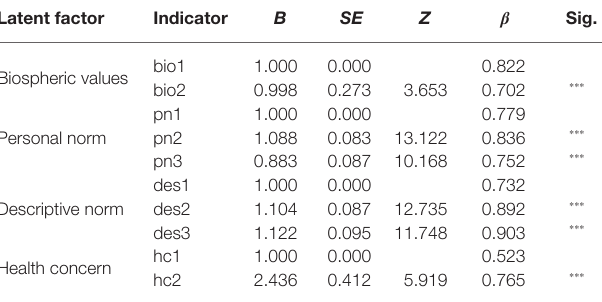
TABLE 4 | Parameter estimates from the four-factor CFA of study 2.